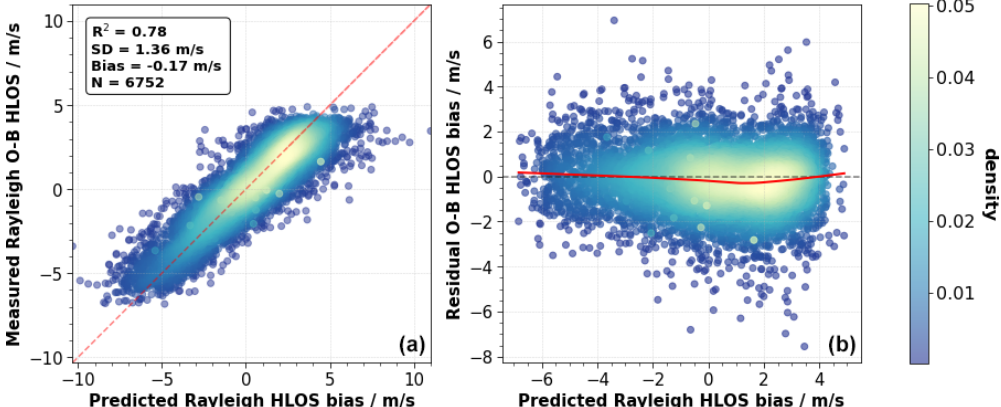
Figure 8. Diagnostic plots for the multiple linear regression with the measured Rayleigh clear E(O − B) values (a) and the model residual (b) as a function of the predicted bias (a) . Data from 11 August 2019 are used to predict the bias on 12 August 2019. The red line in (a) indicates the diagonal. In the text box of (a) values for the coefficient of determination ( R 2 ), standard deviation (SD) ]and the bias of the corrected values, as well as the number of data points (N) used in the regression, are shown. The red line in (b) indicates the smooth function obtained after applying locally weighted smoothing. The color coding in both panels indicates the kernel density.